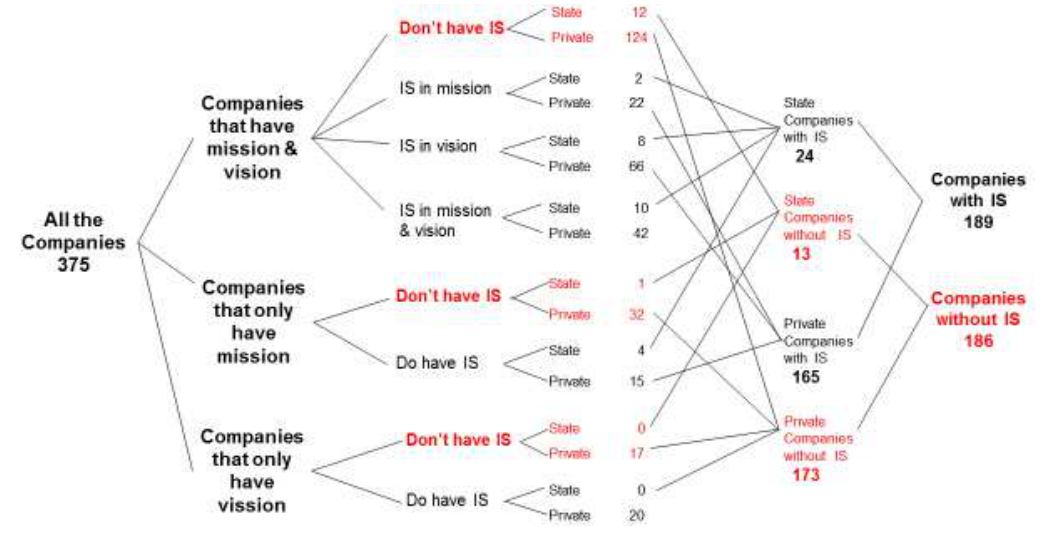
Fig. 1. Presence or absence of IS in the mission, vision or in